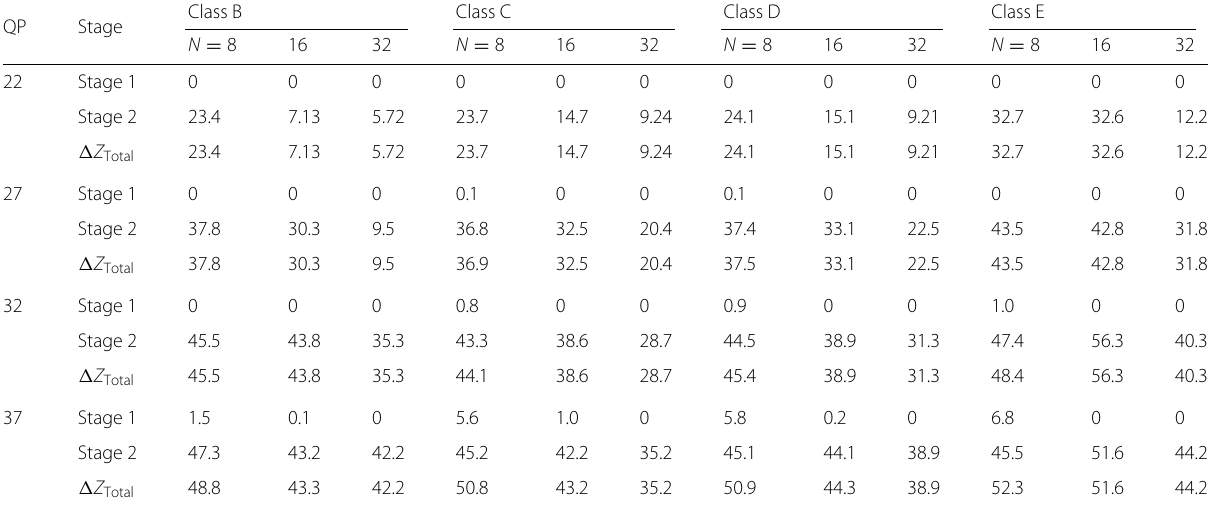
Table 7 Resulting (cid:7) Z (%) values when employing the method proposed by Xie et al. [16] in the first stage